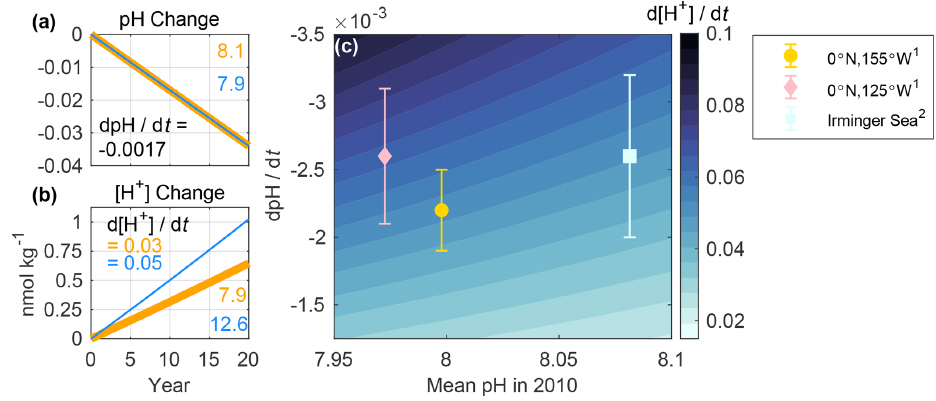
Figure 2. Change in sea surface (a) pH and (b) [H + ] over 20 years at two hypothetical locations. Changes are plotted relative to the initial pH (8.1 and 7.9) and [H + ] (7.9 and 12.6nmolkg − 1 ) values noted in the figures. A fixed pH trend (dpH / d t ) of − 0.0017yr − 1 was imposed at both sites, resulting in [H + ] trends (d[H + ] / d t ) of 0.03 and 0.05nmolkg − 1 yr − 1 . (c) Contour plot showing linearized trends in [H + ] (nmolkg − 1 yr − 1 ) associated with mean (or initial) pH values referenced to the year 2010 and the corresponding pH trends. The y axis is reversed so that larger magnitude pH trends are near the top left corner. Symbols show observed surface ocean pH trends and uncertainties (at in situ temperature) at select time-series sites, in which legend superscripts refer to (1) Sutton et al. (2014) and (2) Bates et al. (2014). A total of 13 additional sites are included in Fig. S1. Details regarding the determination of mean pH values referenced to the year 2010 are described in Text S1, and the values are presented in Table S1. The color map for this figure, and for all subsequent figures, was made using cmocean (Thyng et al.,